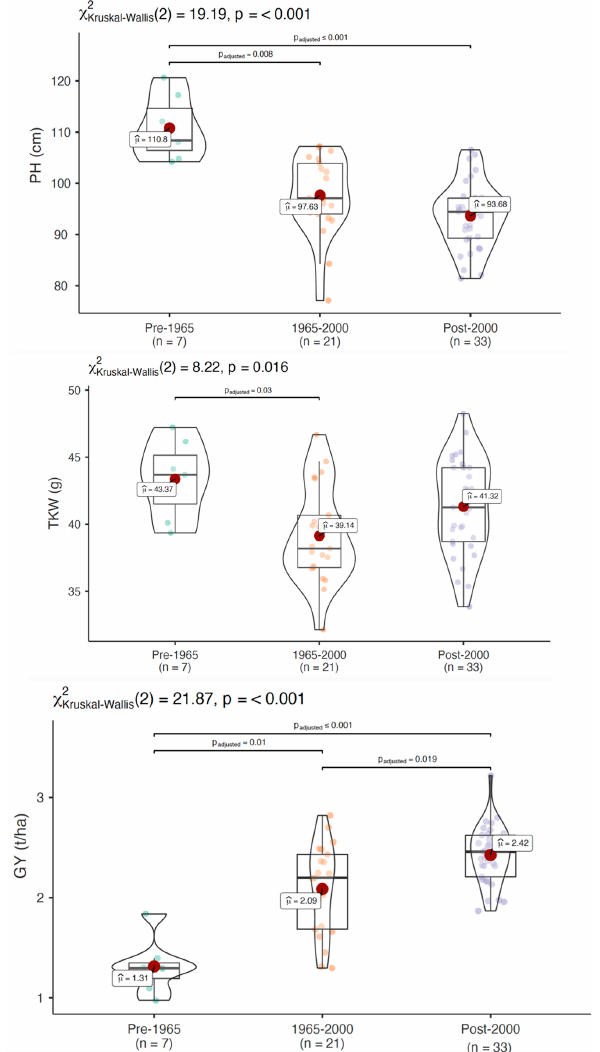
Figure 1. Box plots showing the variation among important micronutrients and yield-related traits distributed over three selective breeding periods. The significance between mean performance of three breeding periods is shown as p value of Kruskal–Wallis test.